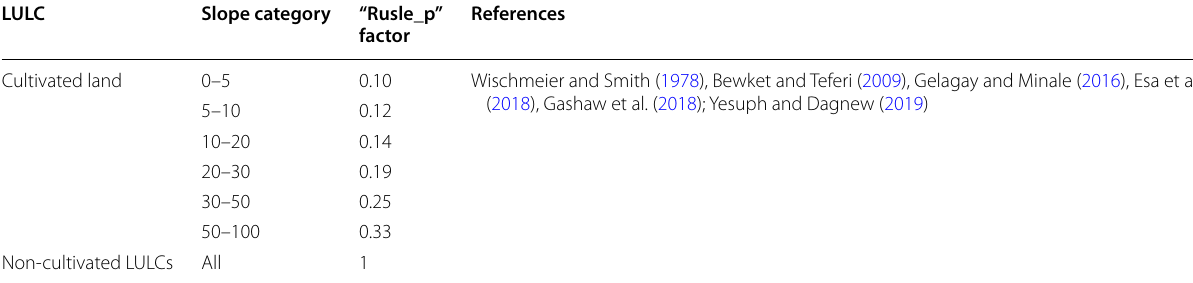
Table 3 Adopted values of “rusle_p” factor LULC Slope